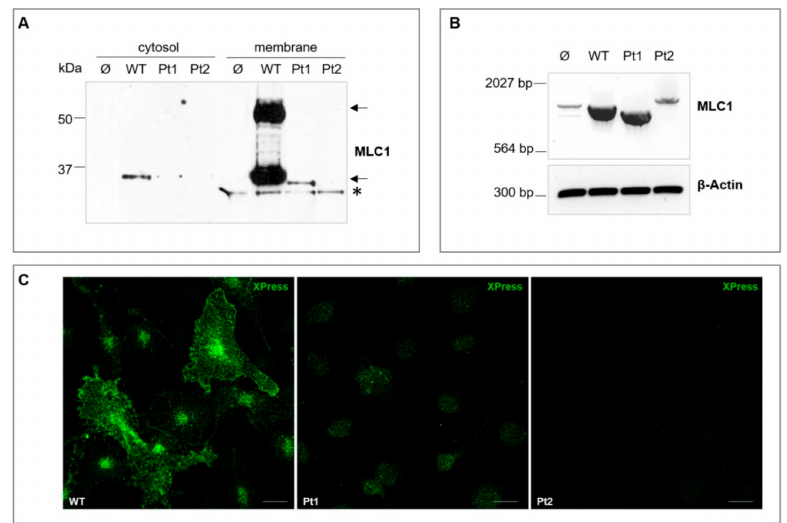
Figure 1. Analysis of MLC1 expression and localization in U251 astrocytoma cell lines infected with empty vector (Ø) or with vectors expressing wild type (WT) or mutant MLC1 (Pt1 and Pt2): ( A )